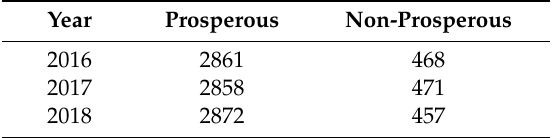
Table 1. Number of prosperous and non-prosperous enterprises in each year.